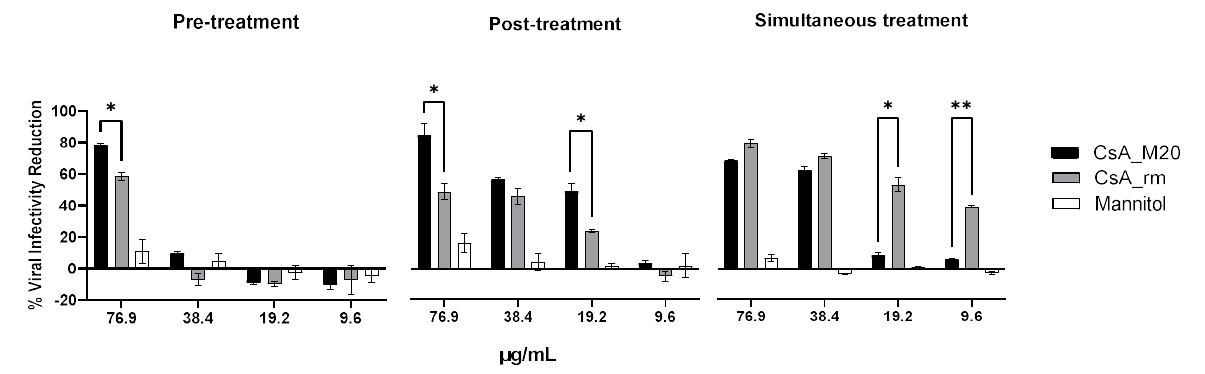
Figure 7. In vitro SARS-CoV-2 Omicron BA.1 infectivity reduction produced by CsA_rm, CsA_M20 or mannitol. Pre-treatment: one hour before infection. Post-treatment: two hours after infection. Simultaneous treatment: cells were infected and treated with the powders at the same time. The mannitol concentrations corresponding to CsA formulation at 76.9, 38.4, 19.2, and 9.6 µg/mL were respectively 15.4, 7.7, 3.8, and 1.9 µg/mL. Data were analysed with two-way analysis of variance